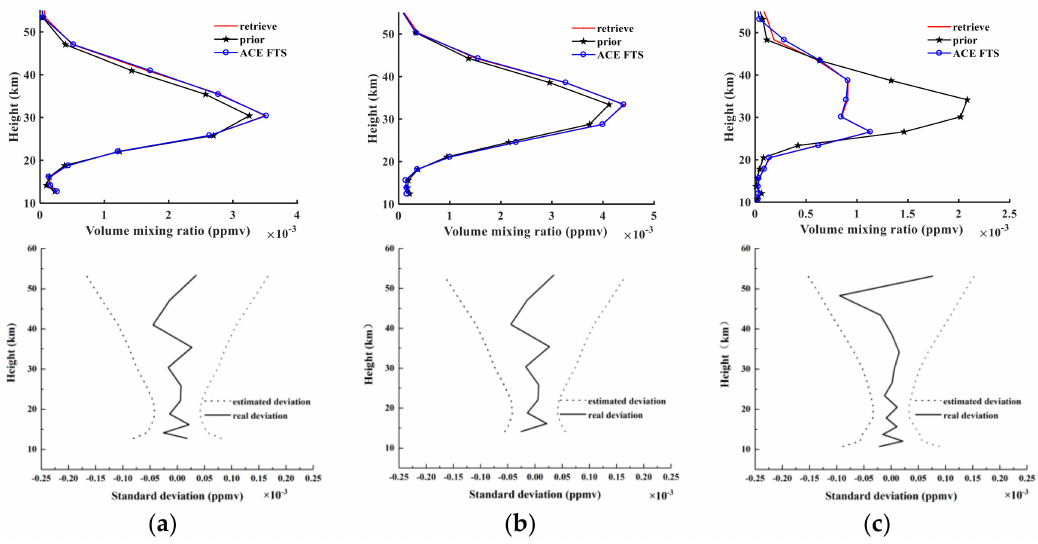
Figure 12. The same as Figure 9 but for NO 2